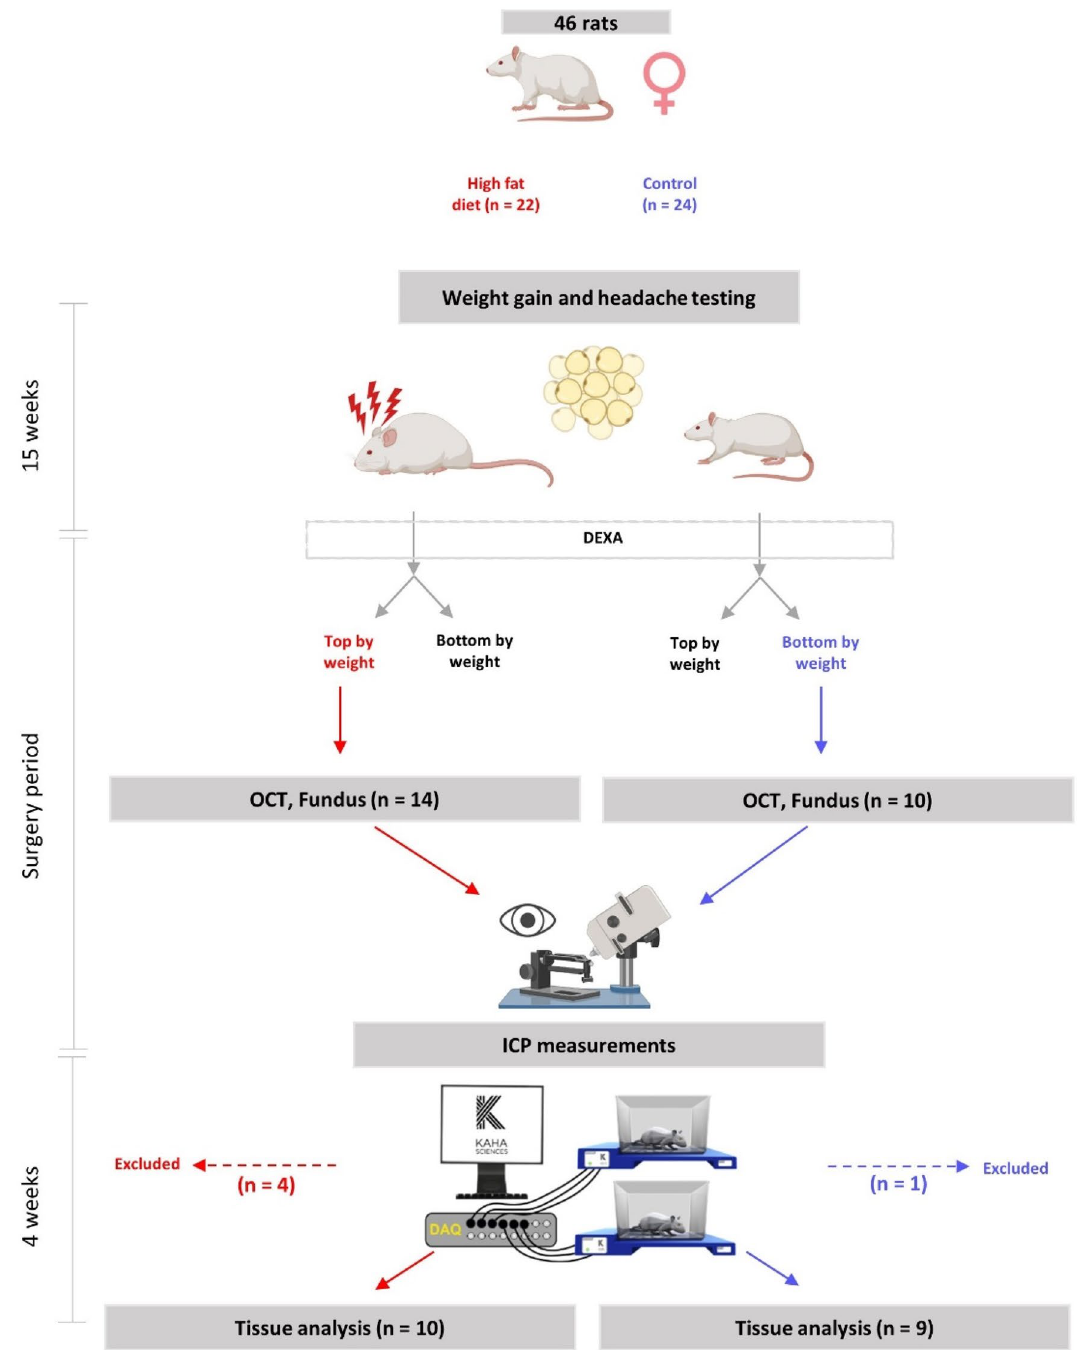
Figure 6. Schematic diagram of the experimental design. Schematic diagram detailing the experimental paradigm and usage of animal during the study. Female rats were on high fat diet or control matched diet for 15 weeks. Von Frey testing was performed during the whole diet period. Following the 15 weeks, Von Frey testing, DEXA scanning and all the eye examinations were performed followed by implantation with ICP telemetric probe for continuous ICP recording (day 0). During the recovery period (day 0–8), the rats were kept single-housed to recover from the surgery and then co-housed (from approximately day 8). Day 8–30 the rats were not affected by anesthesia or any drugs and ICP recordings were continued until day